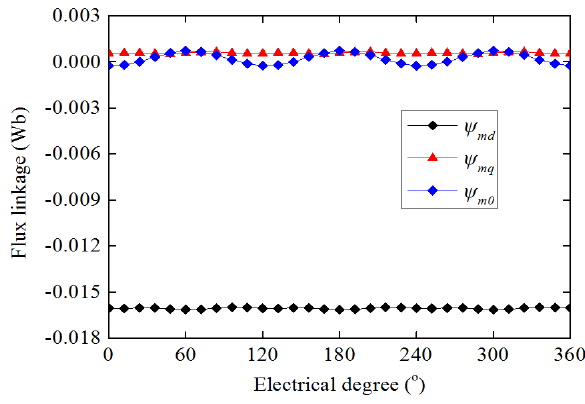
Figure 11. Waveforms of no ‐ load flux linkage in d ‐ q rotating coordinate system.